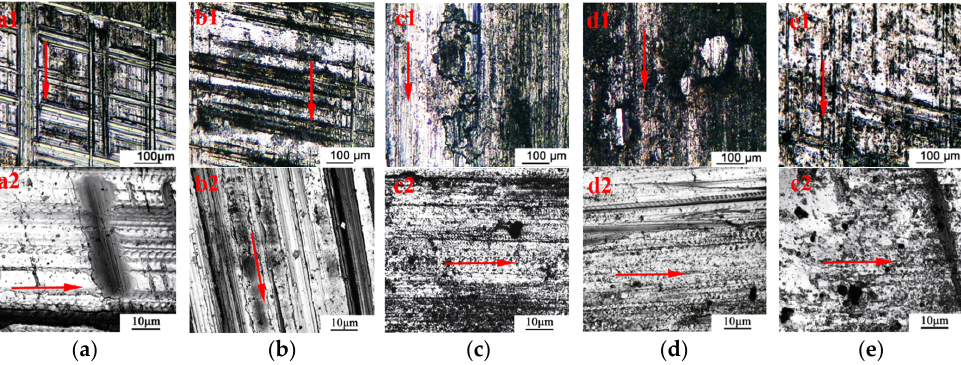
Figure 7. Wear traces on the surfaces of different metal guides of: ( a ) 45 steel; ( b ) slack ‐ quenched 45 steel; ( c ) 7075 alloy; ( d ) Q345B steel; and ( e ) QT700; (1) metallurgical microscope (×100); and (2) confocal laser scanning microscope, CLSM (×1000); and arrows indicate the sliding direction of the slider.